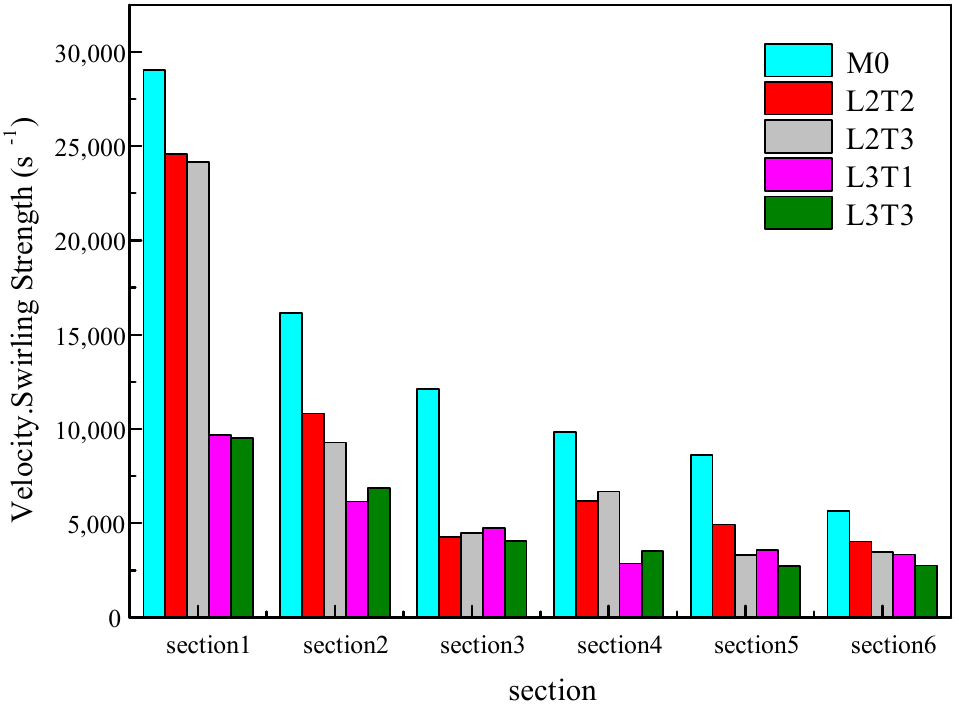
Figure 9. Swirling strength of vortex core comparison for different schemes.